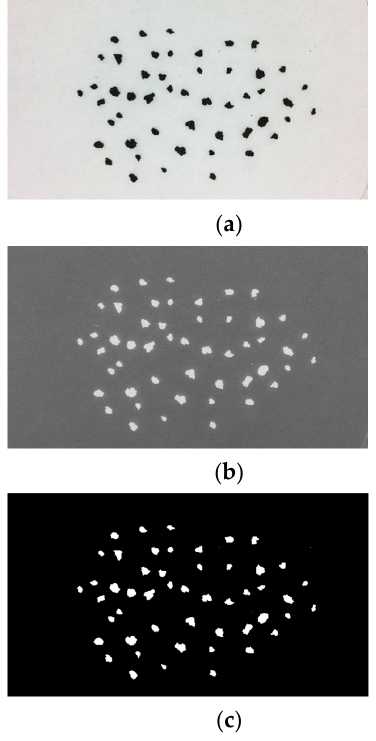
Figure 3. Overview of the image processing flow on a sample image of real volcanic ash particles ( a ); the image after the inversion ( b ) and thresholding ( c ) steps.